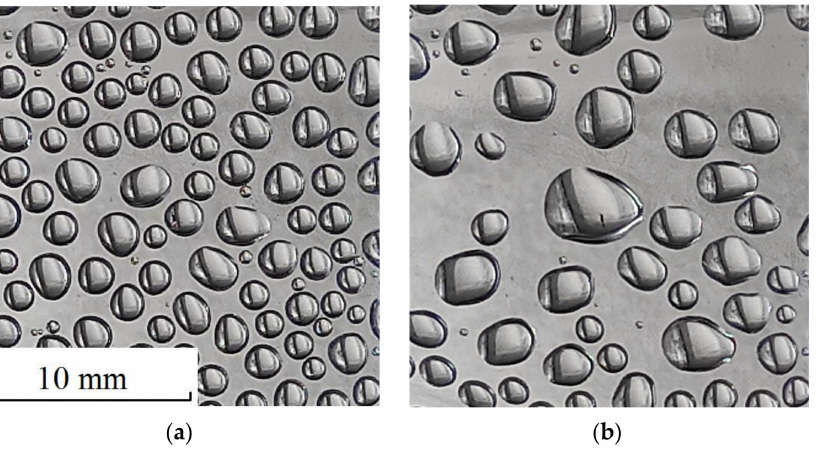
Figure 1. Drops of water on the wall of a plastic bottle before applying high voltage ( a ), after applying high voltage ( b